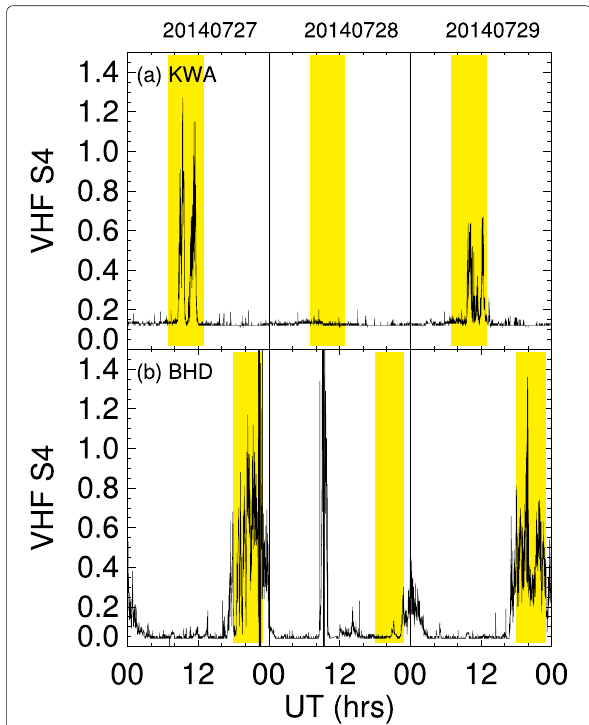
Fig. 3 VHF S4 index measured by the KWA ( a ) and BHD ( b ) ground stations during 27–29 July 2014. The yellow shaded areas indicate 19–02 local time